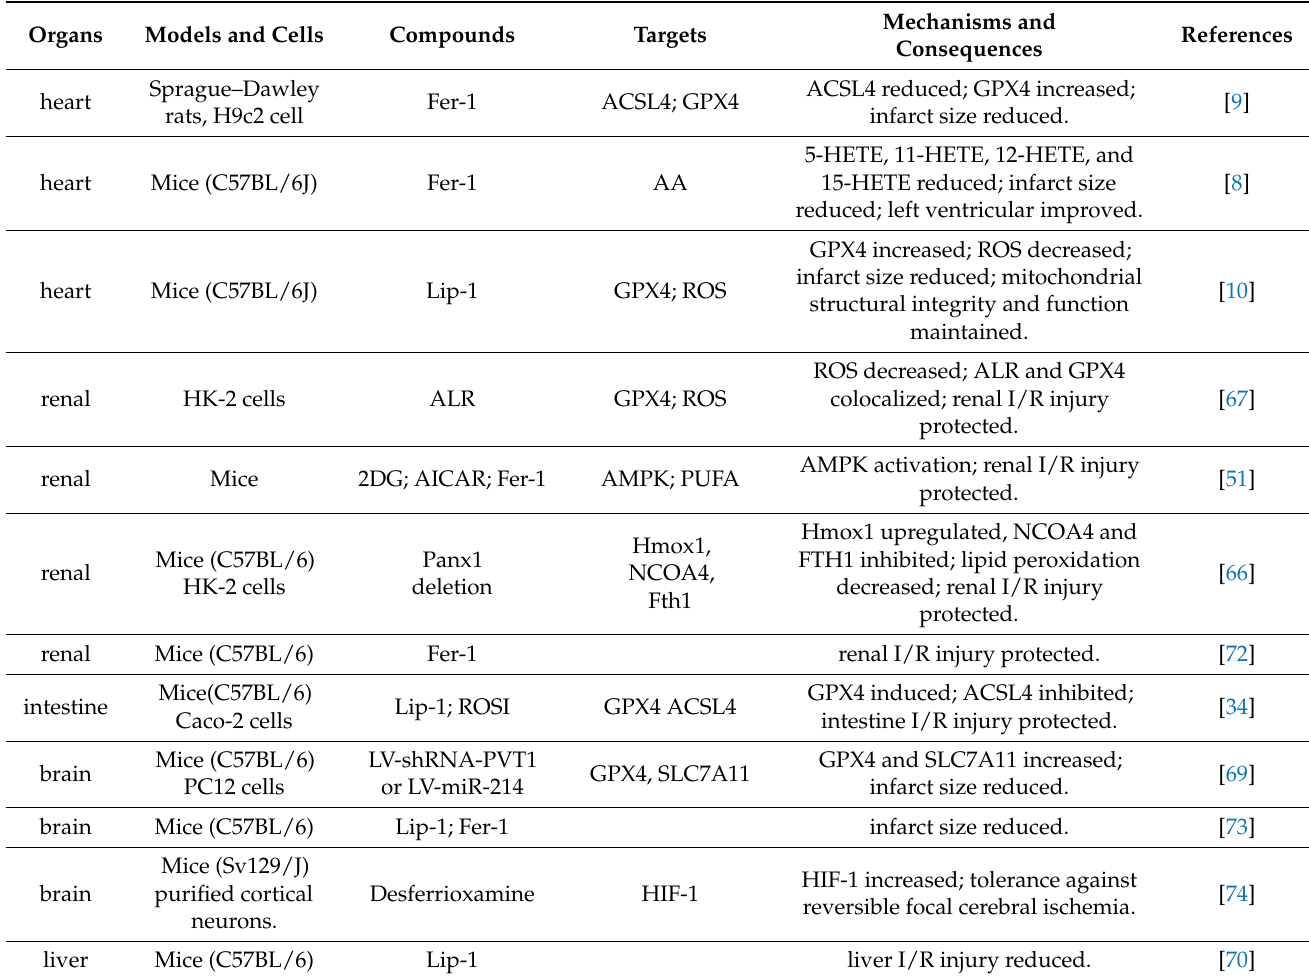
Table 1. Target ferroptosis to reduce I/R injury in different